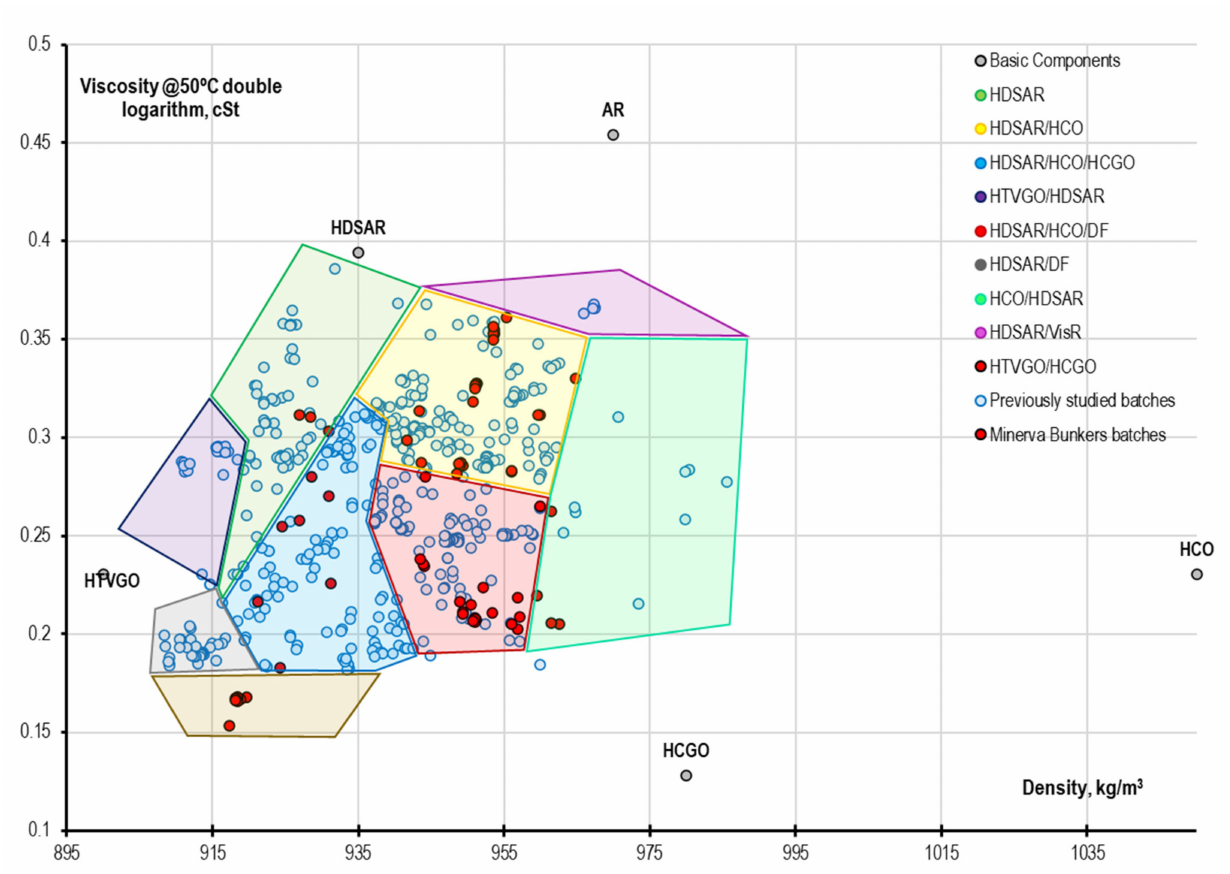
Figure 15. Minerva Bunkers batches in logarithmic coordinates [67]. Table 6. Averaged Minerva Bunkers batches and simulation results